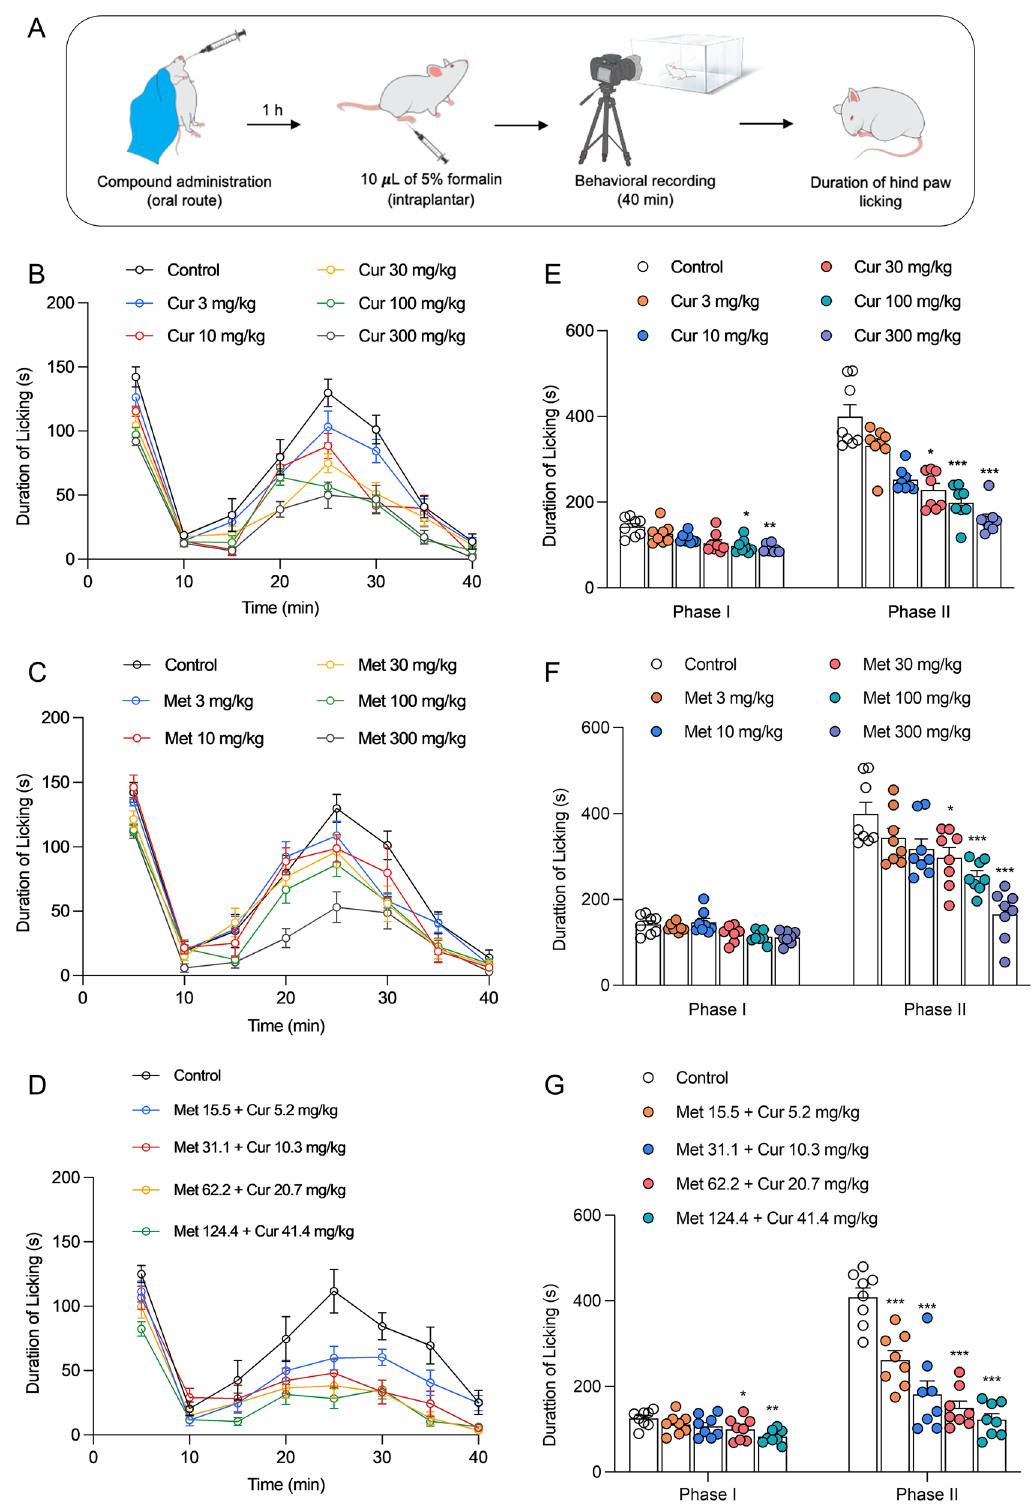
Figure 5. Orally administered curcumin, metformin, and their combination alleviate the formalin-induced inflammatory pain in mice. ( A ) Schematic presentation of the experimental design. ( B–D ) Time course of formalin-induced hind paw licking behavior in mice with oral curcumin ( B ), metformin ( C ), and their combination ( D ). (E–G ) The total duration of hind paw licking during phases I and II of the pain-like behavioral response with the treatment of curcumin (E) , metformin (F) , and their combination (G) . Note that curcumin, metformin, and their combination dose-dependently inhibited phase II response in mice. * p < 0.05, ** p < 0.01 and *** p < 0.001 compared to the vehicle-treated group. One-way ANOVA followed by Bonferroni’s post hoc test, n = 8 mice per treatment